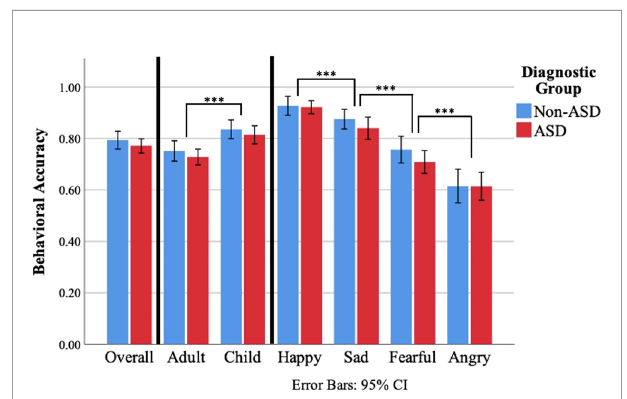
FIGURE 2 | FER percent accuracy for the non-ASD and ASD diagnostic groups on the DANVA-2 by stimulus face age and emotion. Observed main effects of face age and emotion are denoted. A stepwise relationship was observed for comparisons between emotions such that accuracy for happy was signi fi cantly greater than sad, fearful, and angry; accuracy for sad was signi fi cantly greater than fearful and angry; and accuracy for angry was signi fi cantly greater than fearful, all at the p <.001 level. *** p <.001.